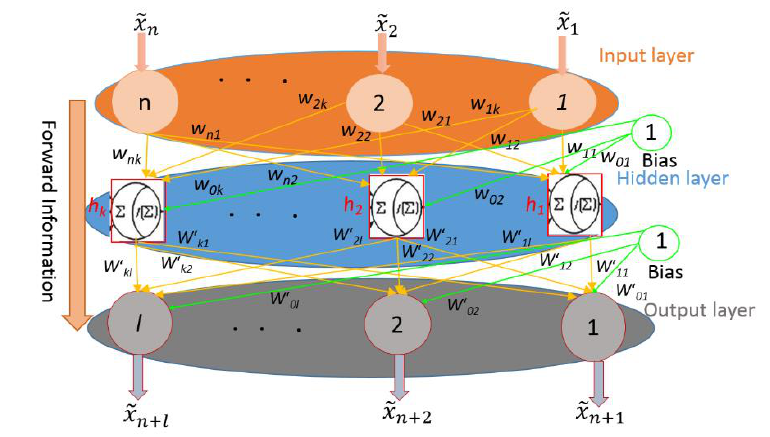
Fig. 1. Architecture of back propagation type